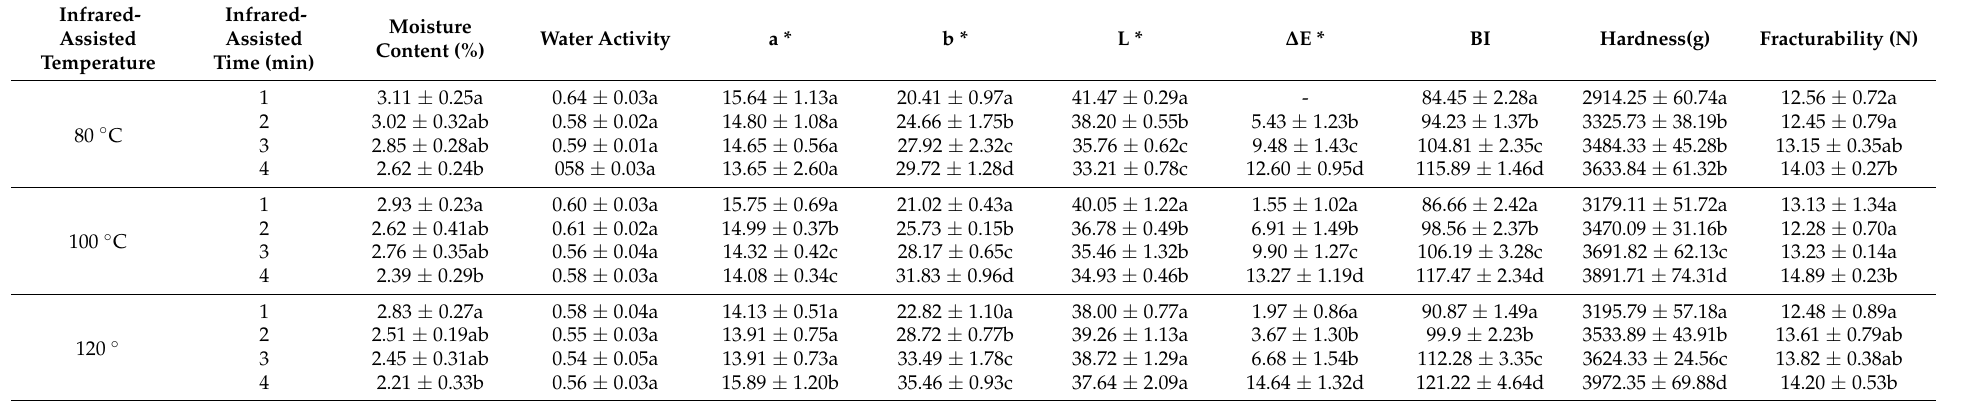
Table 2. Effect of infrared-assisted temperature and deep-frying time on moisture content, water activity (a w ), color parameters, hardness, and fracturability of fried dough twist (FDT). Infrared- Assisted Temperature